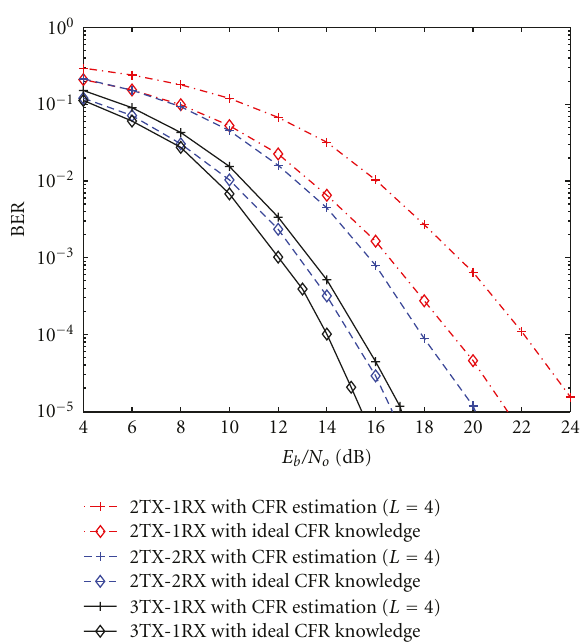
Figure 5: BER performance comparison for 2TX-1RX, 2TX-2RX, and 3TX-1RX with linear